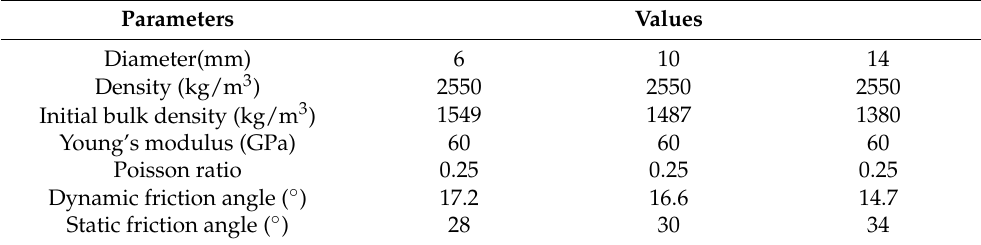
Figure 2. Schematic diagram of granular material: ( a ) d = 6 mm; ( b ) d = 10 mm; ( c ) d = 14 mm. Table 2. Properties of granular materials. Table 2. Properties of granular